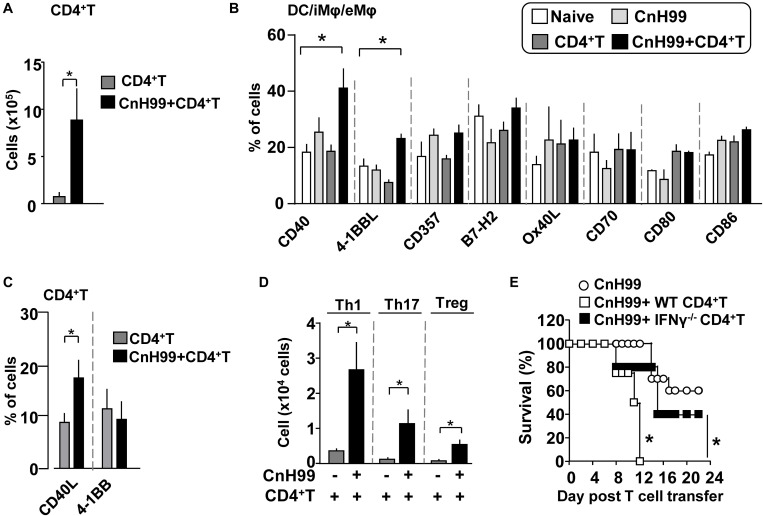
Evaluation of CD4+ T cells and APCs in C-IRIS. (A) Comparison of lung CD4+ T cell counts between groups with C-IRIS vs. T cell transfer alone. (B) Expression of co-stimulatory molecules on CD45+CD11c+F4/80– cells. (C,D) Percentages of CD4+ T cells expressing CD40L or 4-1BB (C). Numbers of Th1, Th17, and Treg cells in the lung (D). (E) Survival C-IRIS-induced mice with Ifng– /– CD4+ T cell or wild type CD4+ T cell. A control group with infection alone received vehicle (PBS with 2% FBS) injection at the same time with T cell transfer for test groups. Day 0 was set 3 weeks after infection. Except for (E), evaluations were performed at 4 weeks post infection and/or 1 week after T cell transfer, and the treatment protocol of groups is indicated in Supplementary Figure 1A. n = 5 mice per group for all experiments. The results are representatives from at least two independent experiments. Student’s t-test for (A,C,D), one-way ANOVA and Tukey post-hoc test for (B), and Log-rank analysis for (E) were used for statistical analyses; *p < 0.05.